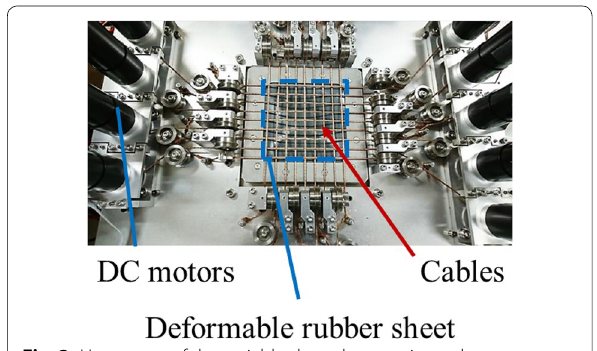
Fig. 3 Upper part of the variable shape human tissue